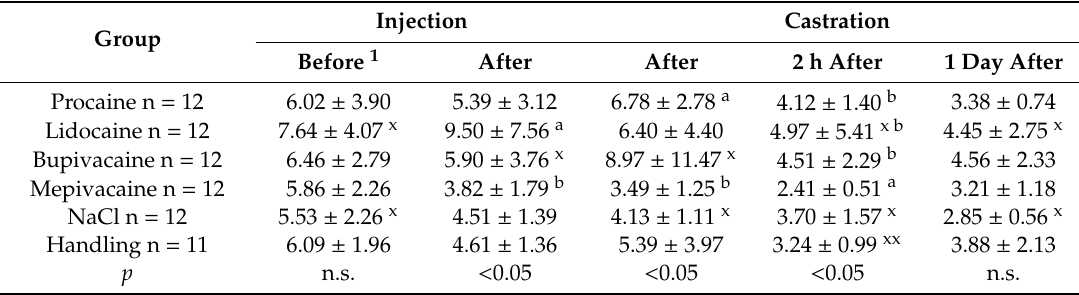
Table 4. Mean values and standard deviation of navigation time in seconds of the piglets through the handling chute according to Bilsborrow et al. [28] in di ff erent groups before injection, after injection, after castration, two hours after castration and one day after